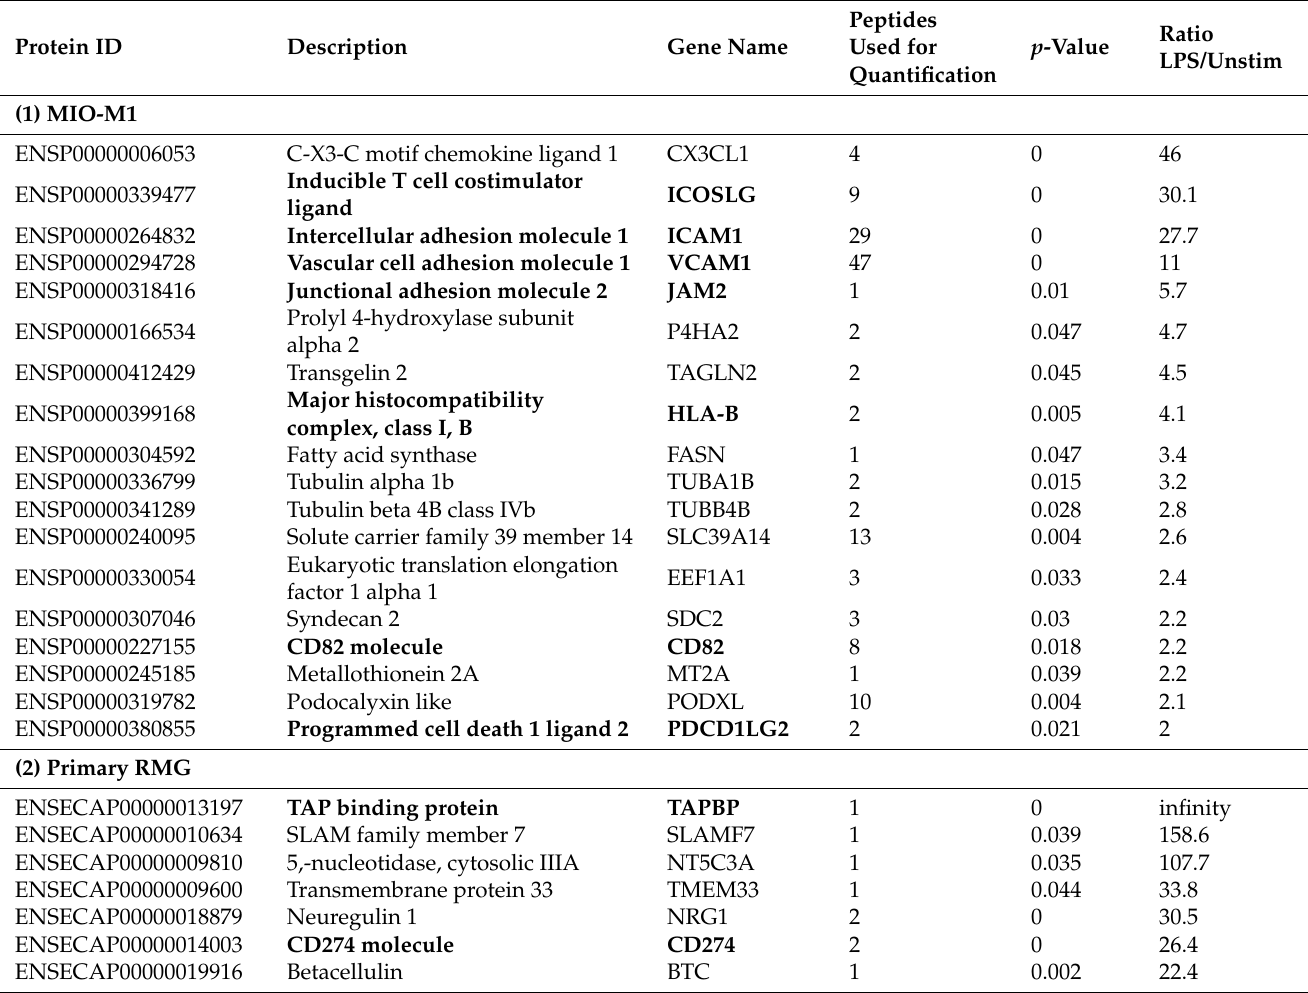
Table 1. Proteins from mass spectrometry dataset with statistically significant ( p ≤ 0.05) abundance changes (ratio ≥ 2) after LPS stimulation (1) in MIO-M1 cells and (2) in primary retinal Müller glial cells